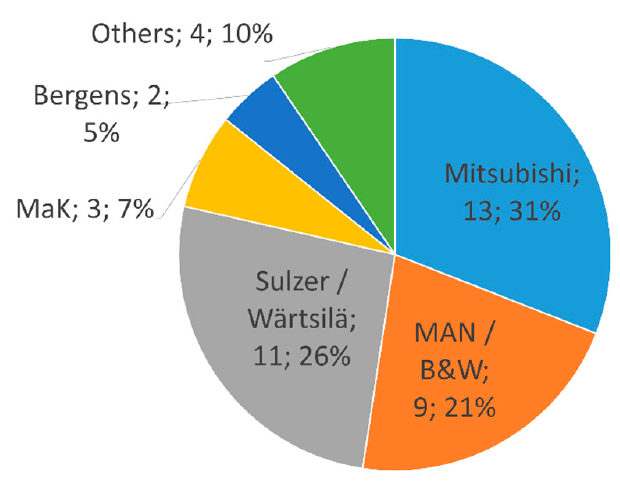
Figure 14. Number of main engine turbocharger explosions as a function of the engine’s design.